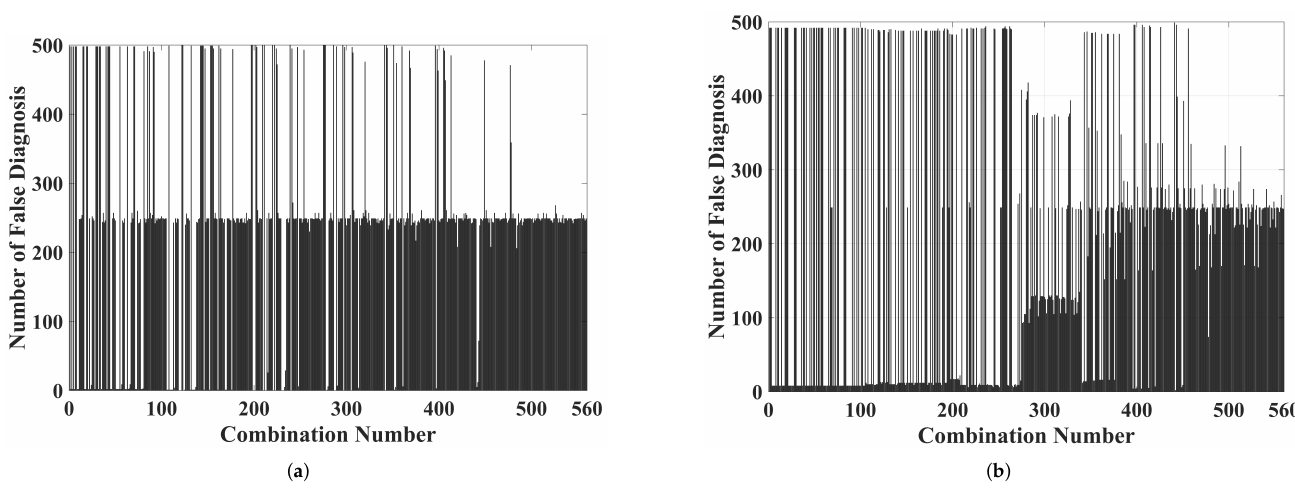
Figure 12. The number of false diagnoses for each combination (presented in the Appendix A) of three levels for ( a ) approximation and ( b ) detail coefficients.